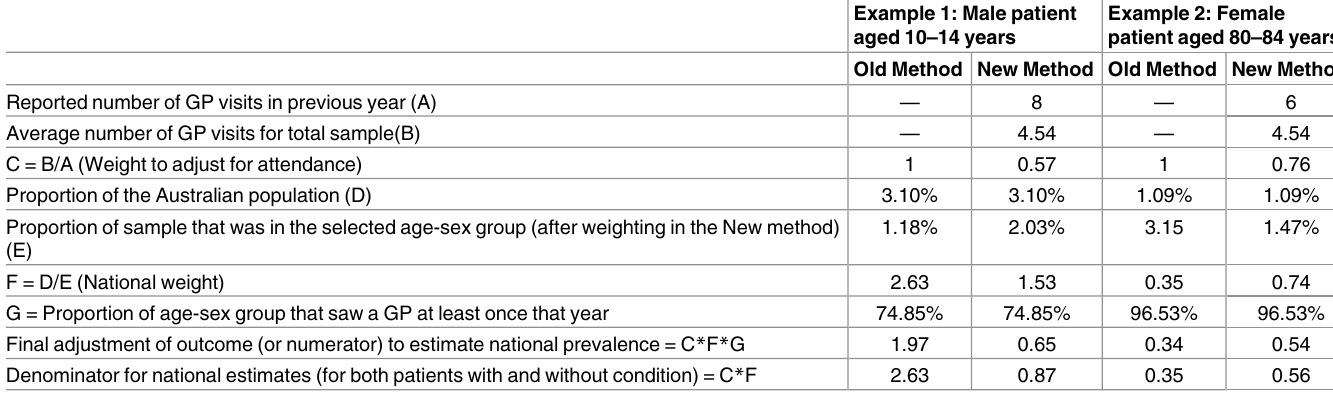
Table 1. New and previous methods to weight “encounter” data to reflect “population”